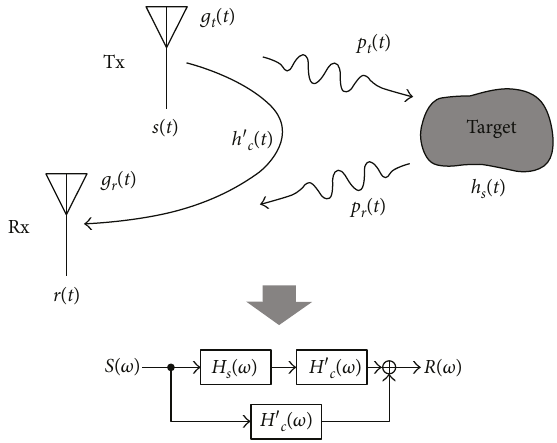
Figure 1: Basic model of a bistatic radar